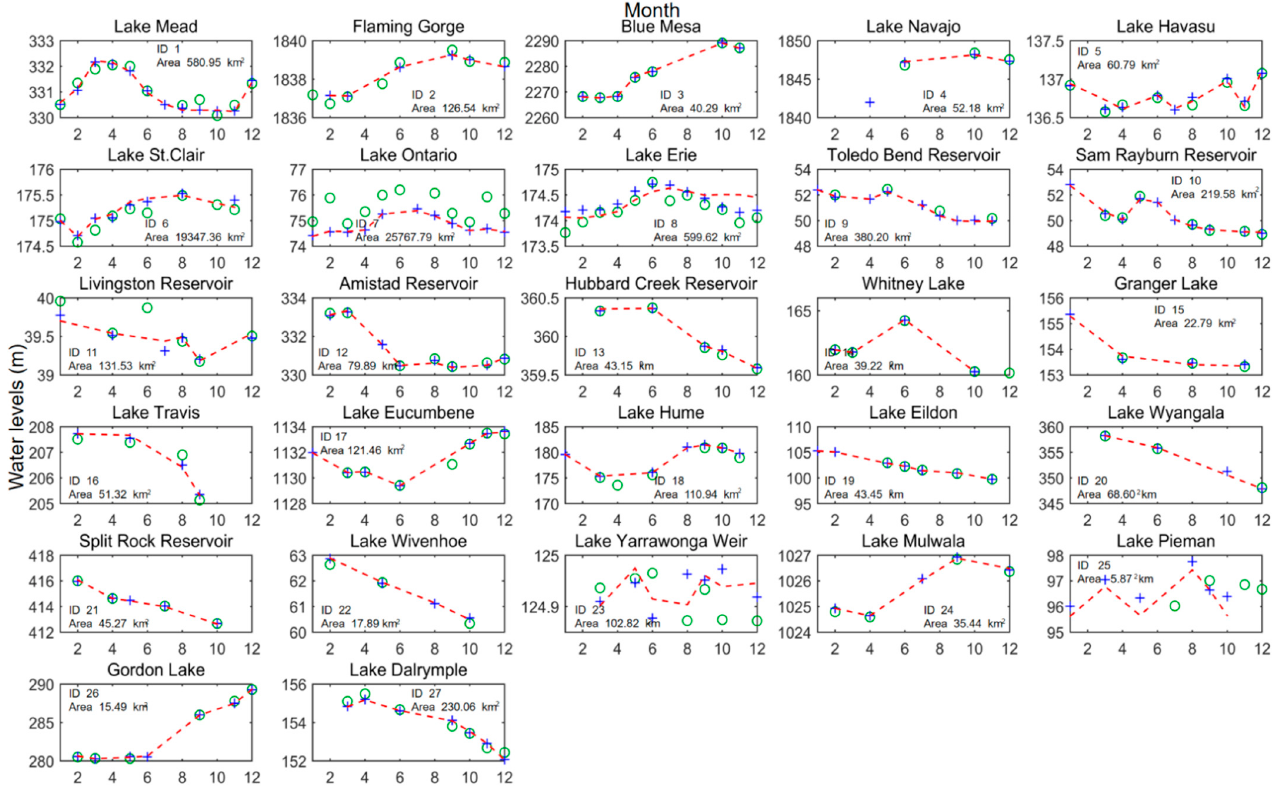
Figure 6. Comparisons between monthly water levels in 2019 from our ATL13-derived results, ATL08-derived results in the study by Cooley et al. [28], and in situ water level data of 27 lakes and reservoirs in the United States (Figure 3a) and Australia (Figure 3c). The red dotted curves correspond to the in situ water levels from gauge stations, blue crosses correspond to the water levels from ATL13 products, and the green circles correspond to the results from the ATL08 products.. Areas of lakes/reservoirs were also presented. Note that all water levels from ATL13-derived results, ATL08-derived results, and in situ measurements were based on or transformed into orthometric heights with respect to the EGM2008 geoid for each lake/reservoir via VDatum Tool (https://vdatum.noaa.gov/vdatumweb/, accessed on 3 May 2021).